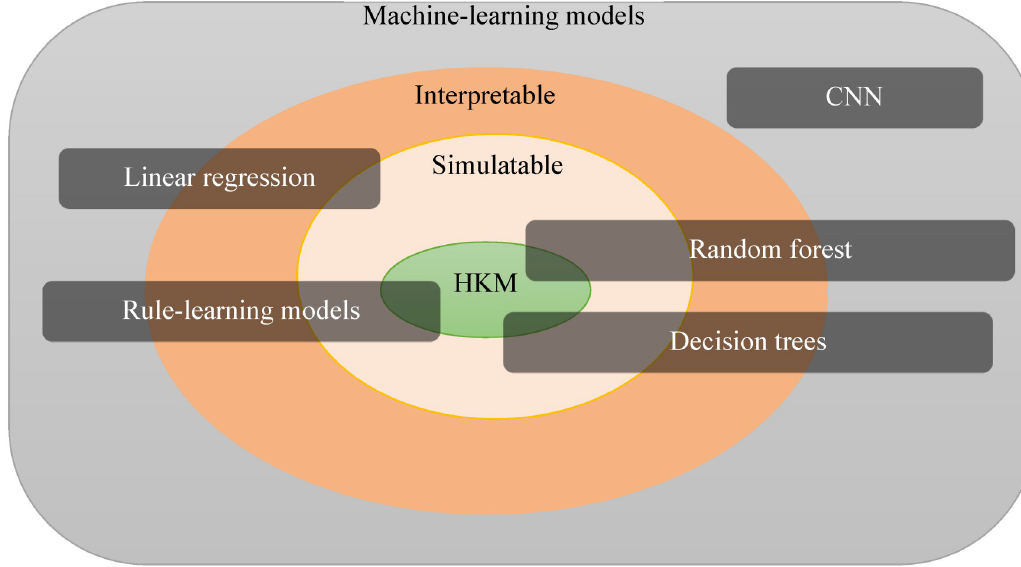
Fig 1. HKM and machine learning. HKMs can be viewed as more constrained forms of several classical ML models (such as logic rule-learning), but they will be distinctly different from any hard-to-compute ML (regression, CNN).